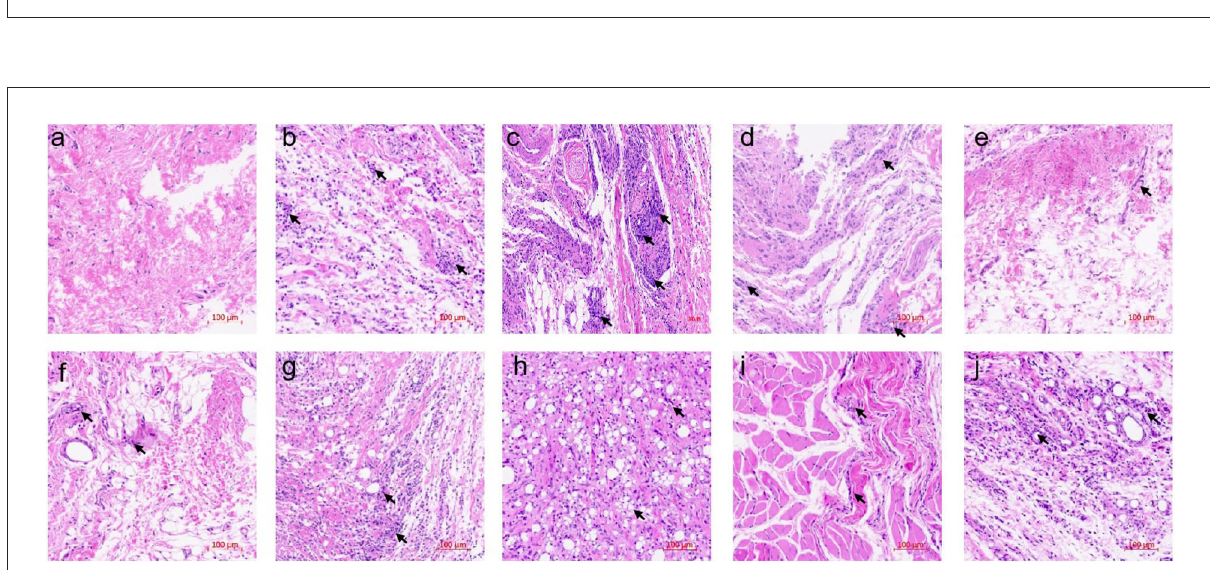
FIGURE5 Histological sections of rat articular tissues showing severe cartilage damage, capillary hyperplasia, synovial proliferation, and lymphocyte infiltration (200 × magnification). (a) Normal control (Con) group; (b) model (CFA) group; (c) negative control (NC) group; (d) positive control (PC) group; (e) PCEO group; (f) PFEO group; (g) ROEO group; (h) SJEO group; (i) LAEO group; (j) AREO group. Arrows indicate the lesion